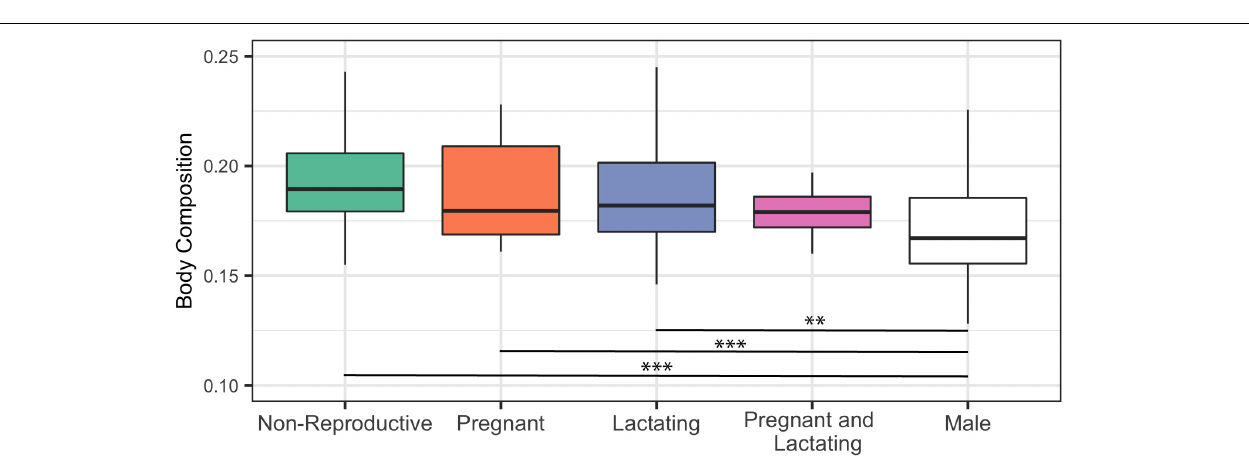
FIGURE 6 | Body composition of mature female ( n = 127) common bottlenose dolphins ( Tursiops truncatus ) of differing reproductive status and adult male ( n = 150) common bottlenose dolphins in Sarasota Bay. Significance from Dunn test results are indicated by two asterisks ( p < 0.001) and three asterisks ( p <